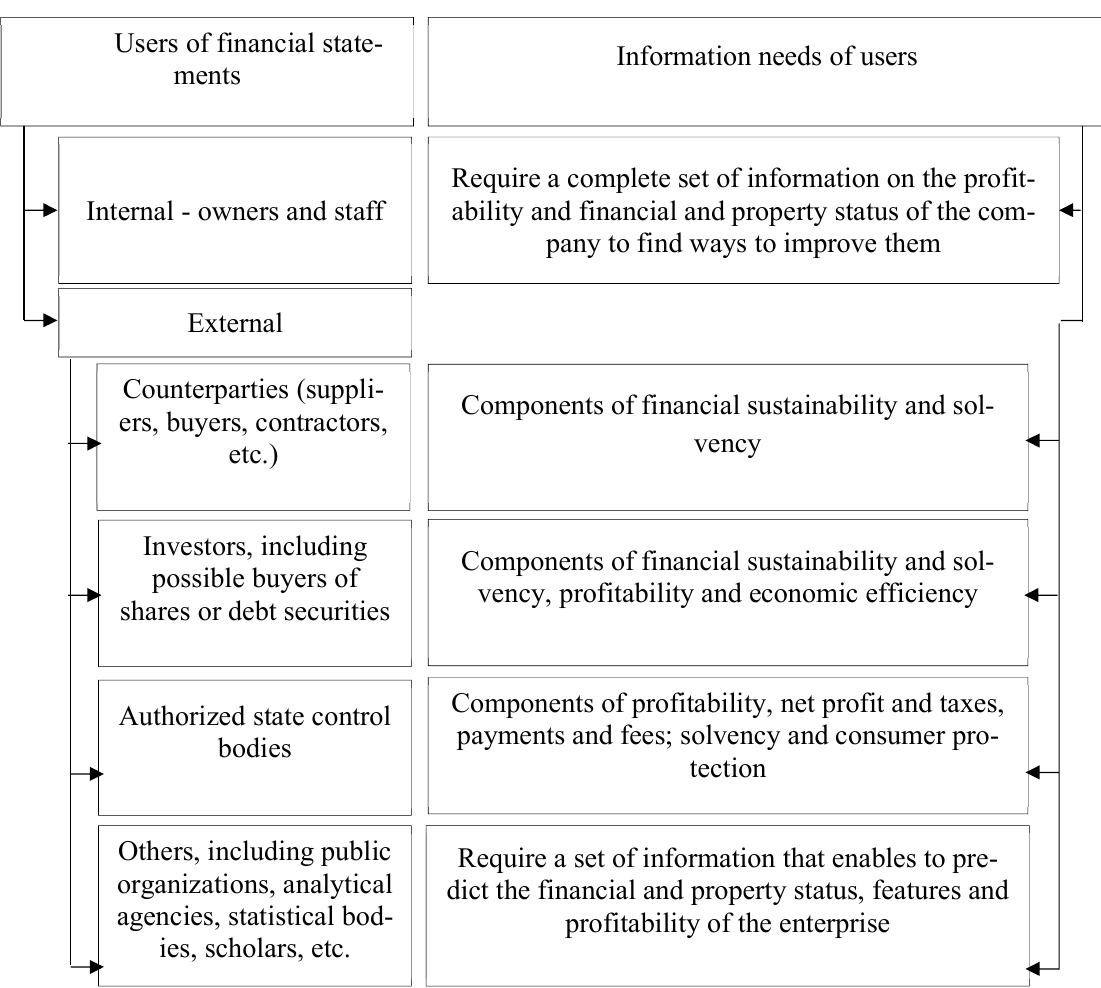
Fig. 1. Information needs of users of financial